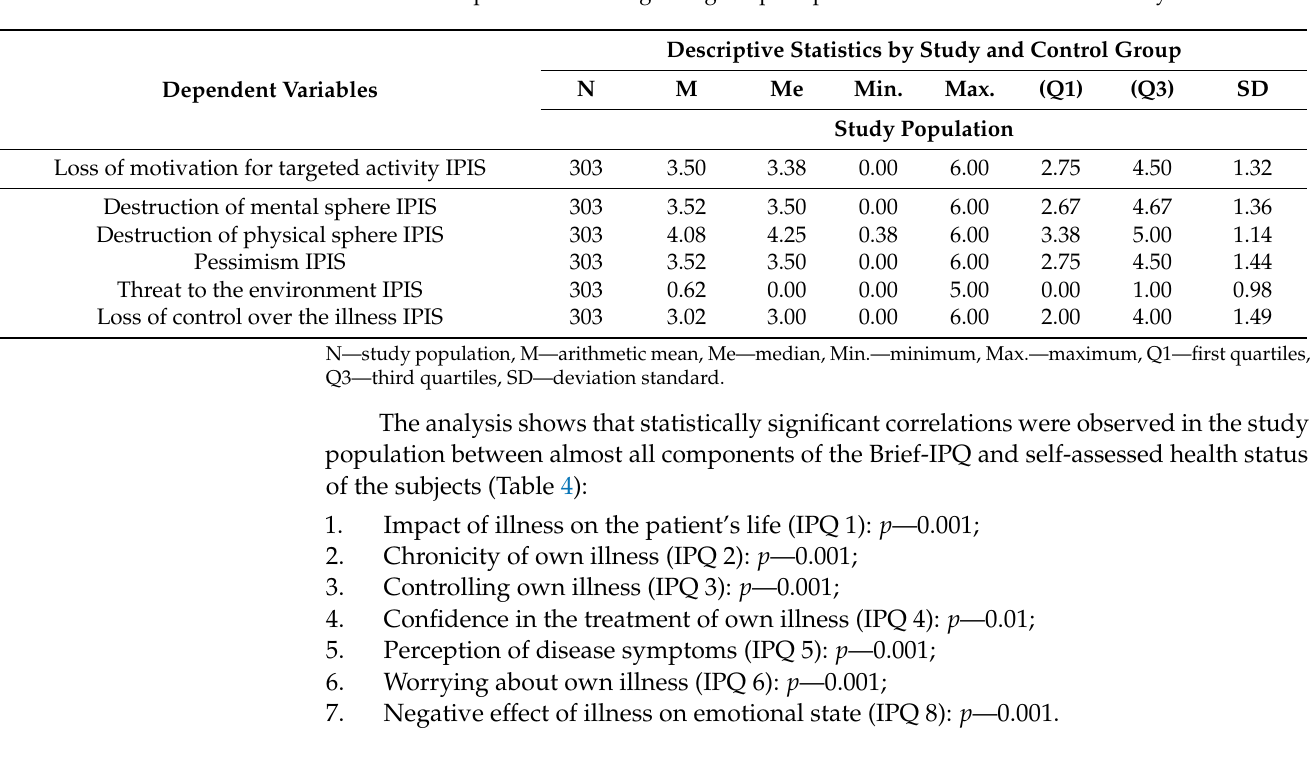
Table 4. Perception of own illness as measured by the Brief-IPQ vs. age, self-assessed health status and duration of